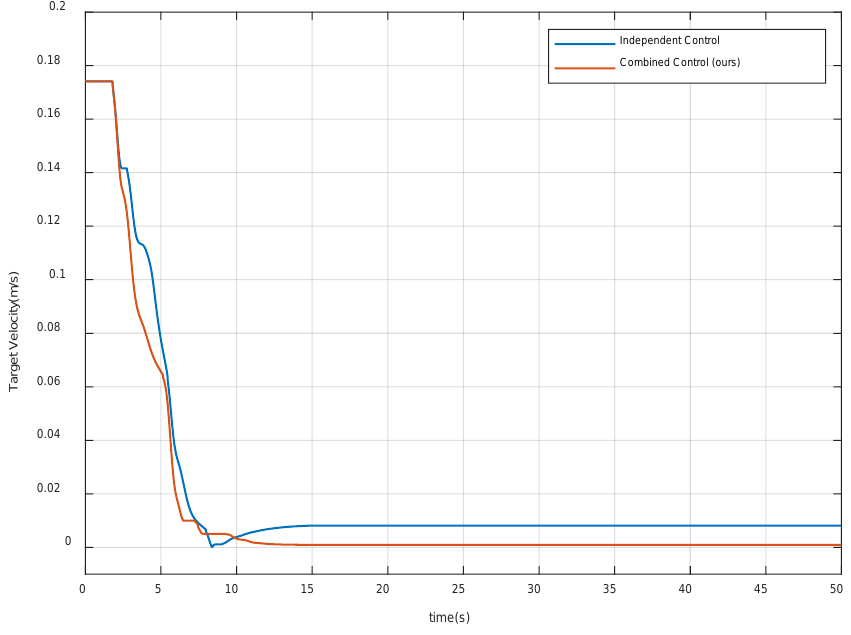
Figure 14. Velocity of the target spacecraft.